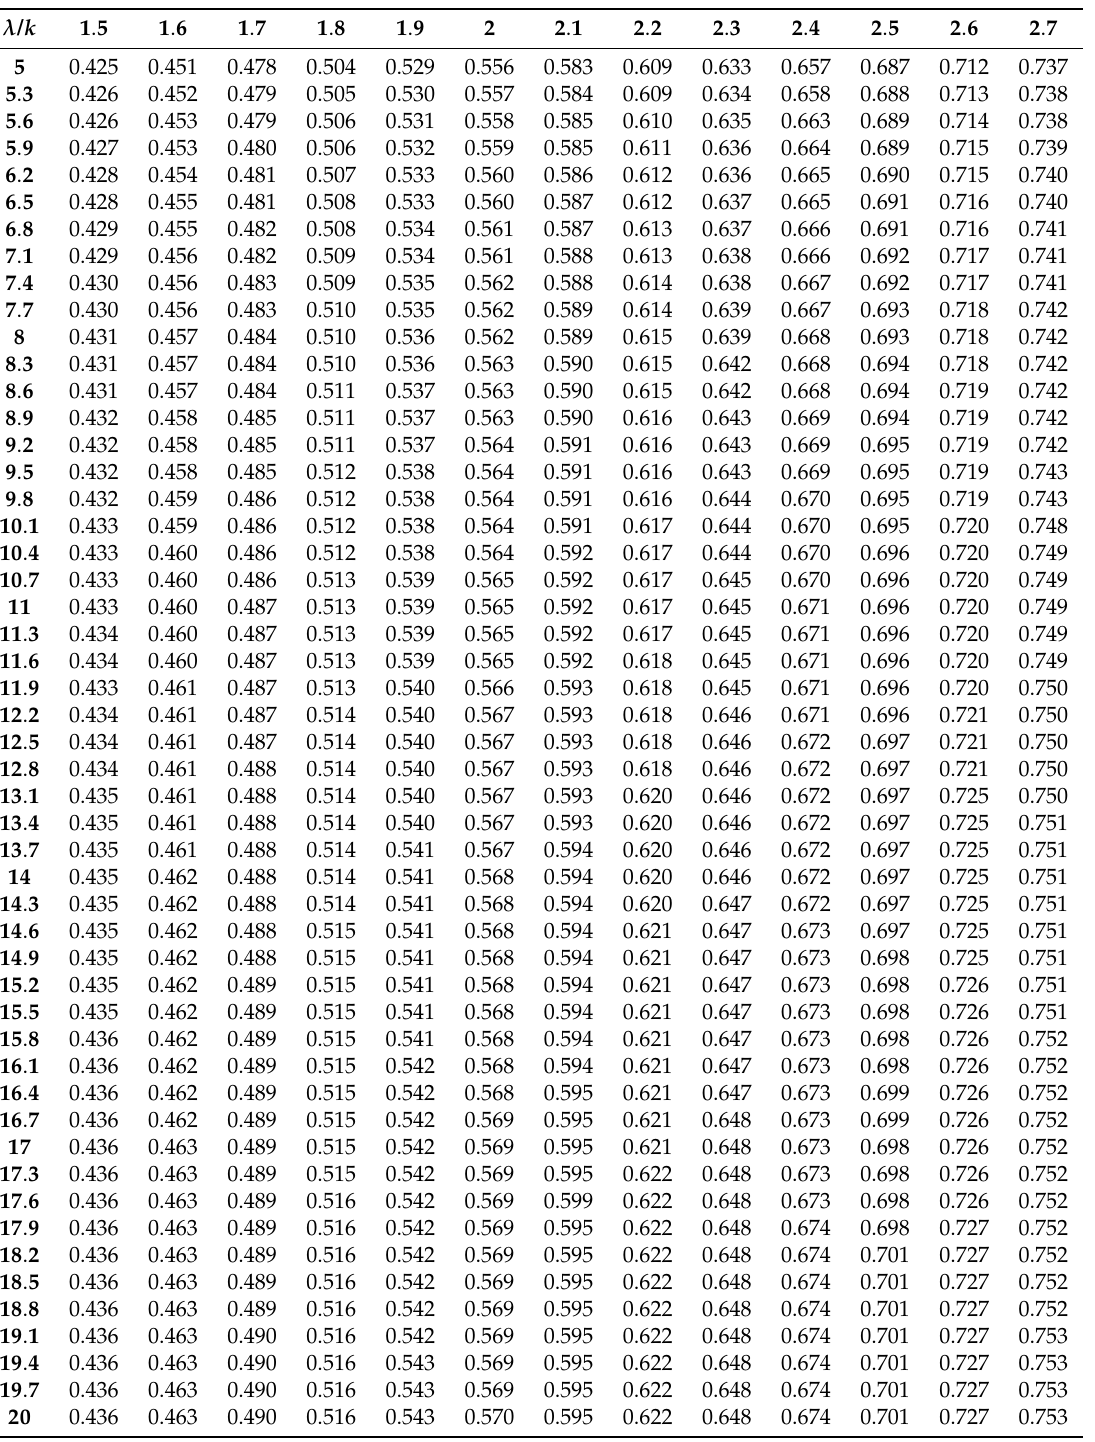
Table A1. Optimal exponent α opt for k and λ values in the ranges 1.5 ≤ k ≤ 4 and 5 ≤ λ ≤